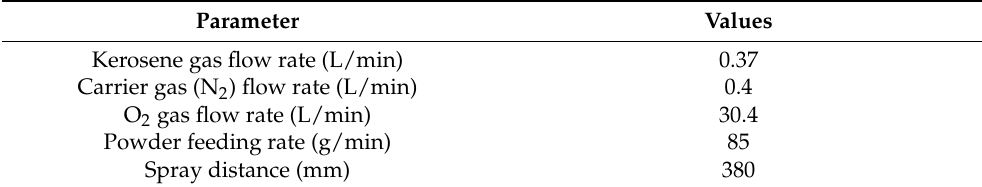
Table 2. Spraying parameters of WC–10Co–4Cr by HVOF. Parameter Values Kerosene gas flow rate